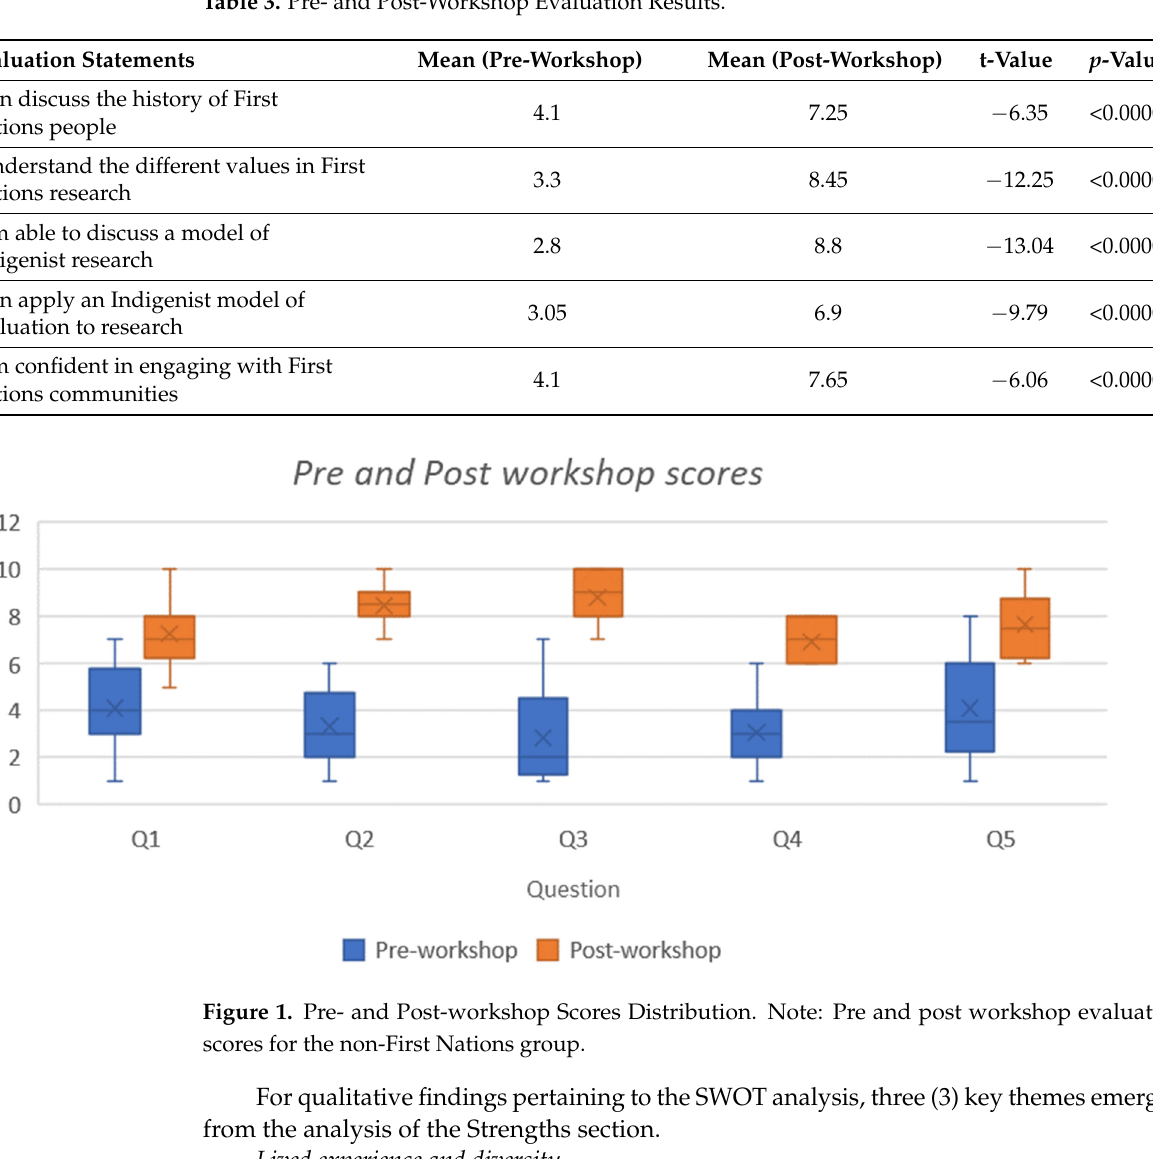
Table 3. Pre- and Post-Workshop Evaluation Results.